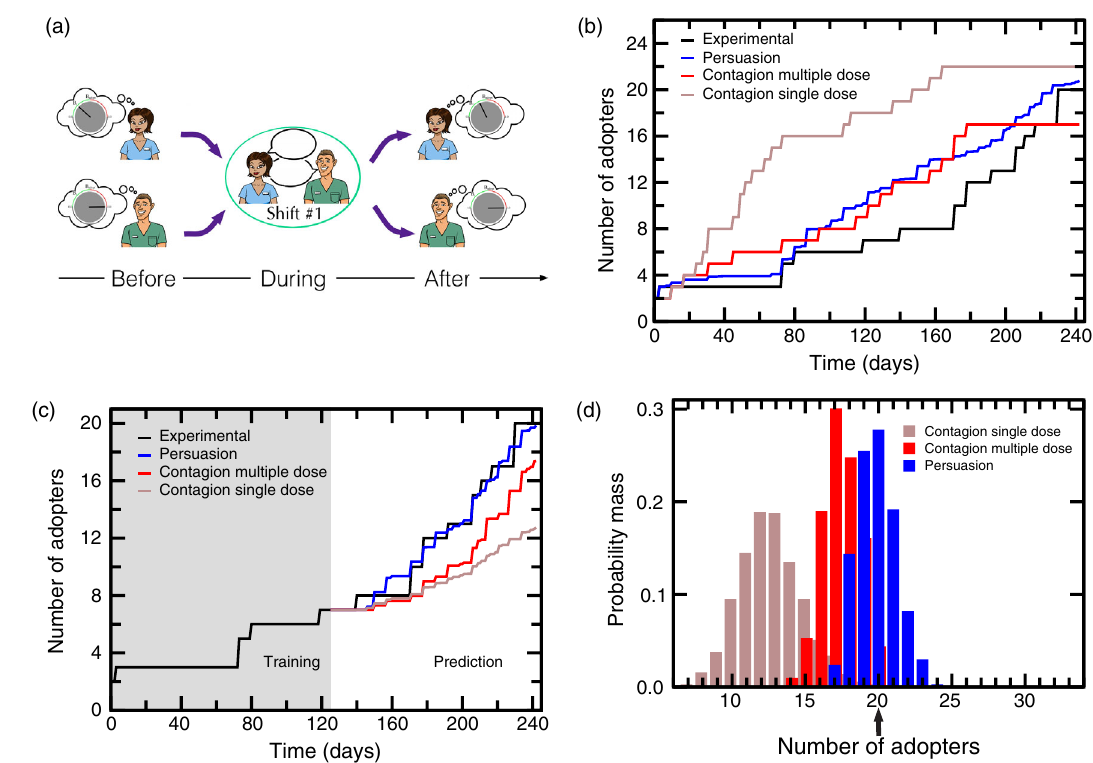
FIG. 2. Computational modeling of the adoption experiment. (a) Schematic of the adoption interaction dynamics between two physicians in the study. Each physician enters each interaction with a belief level B in the innovation with range [0, 1] represented as a i ≥ B dial. If B , the physician is an adopter (red dial). We assume an adopter can expose other physicians to knowledge about the i adopt innovation (the PCTassay) only during a shared work shift. As a result of the interaction, physicians may change their opinion. (b) Mean number of adopters over time for the different adoption models and their corresponding best-fit parameters (contagion with multiple ¼ 1 , P ¼ 0 , and dose ¼ 0 . 2 ; contagion with a single dose P ¼ 1 and P ¼ 0 ; and persuasion B ¼ 0 . 5 , P ¼ 0 . 1 , doses P inf imm inf imm adopt M ¼ 0 , and R ¼ 0 ) determined for 1000 simulations compared to experimental data (black line). (c) To test the prediction power of the models, we fit the contagion (with single and multiple doses) and persuasion models to the data for a training period (gray area; ¼ 125 days is illustrated). We determine the best-fit set of parameter values (contagion with a single dose P ¼ 0 . 1 and T training inf ¼ 0 ; contagion with multiple doses P ¼ 0 . 1 , P ¼ 0 , and dose ¼ 0 . 4 ; and persuasion B ¼ 0 . 5 (fixed), R ¼ 0 (fixed), P imm inf imm adopt P ¼ 0 . 1 , and M ¼ 0 ). We then use these optimal parameter values and the empirical conditions at the end of T as new initial training conditions to simulate the models for the remainder of the experiment ( 244 − T ), using 1000 independent realizations of each training model. (d) Distribution of the final number of adopters predicted by the three models considered. We indicate the experimentally observed final number of adopters with the arrow. These data show that the persuasion model is the only one consistent with the experimental data. See the main text and Table I for more details on the model comparisons and